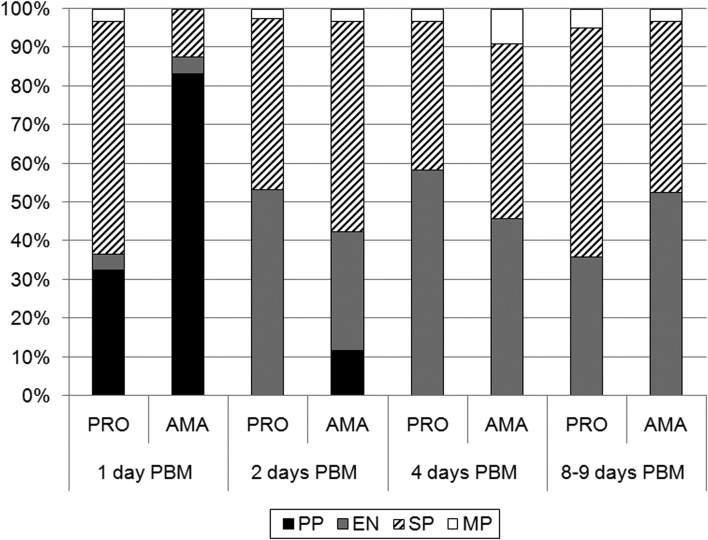
Morphological forms of L. donovani during development in P. argentipes. The guts of infected females were sampled at 1, 2, 4 and 8–9 days PBM and parasite morphometry was determined as described in methods. The percentage of each form found in infected flies at each time point is shown. PRO, promastigote-initiated infections; AMA, amastigote-initiated infections; PBM, post bloodmeal; PP, procyclic promastigotes; EN, elongated nectomonads; SP, short promastigotes; MP, metacyclic promastigotes. Differences between groups were tested by Chi-square test: day 1 PBM, P < 0·0001, χ2 = 68·115, d.f. = 3, day 2 PBM, P < 0·0001, χ2 = 22·581, d.f. = 3, day 4 PBM, P = 0·058, χ2 = 5·707, d.f. = 2, day 8–9 PBM, P = 0. 034, χ2 = 6·786, d.f. = 2.